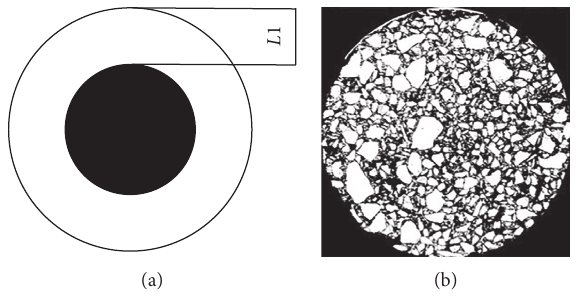
Figure 3: Gap width calculation schematic